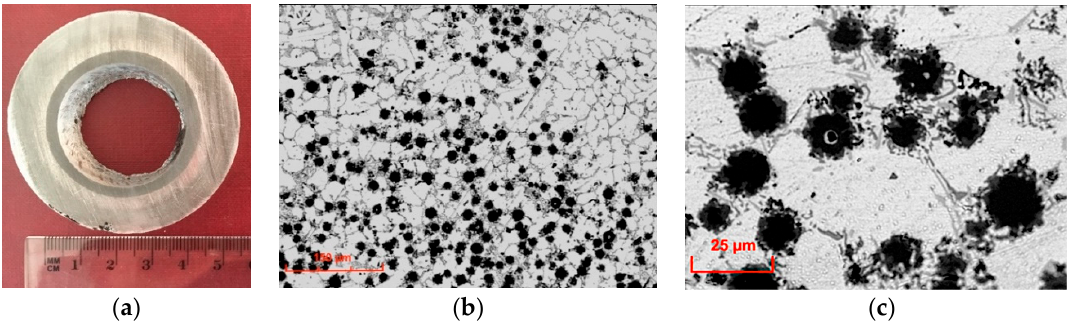
Figure 6. Cross-section perpendicular to the rotational axis of the centrifugal cast obtained with AlSi7Mg1Sr0.03/GC sf 5 wt.% composite suspension: ( a ) Macrostructure with a visible inner composite layer; ( b ) and ( c ) Microstructure of GC sf particle-rich region, LM.